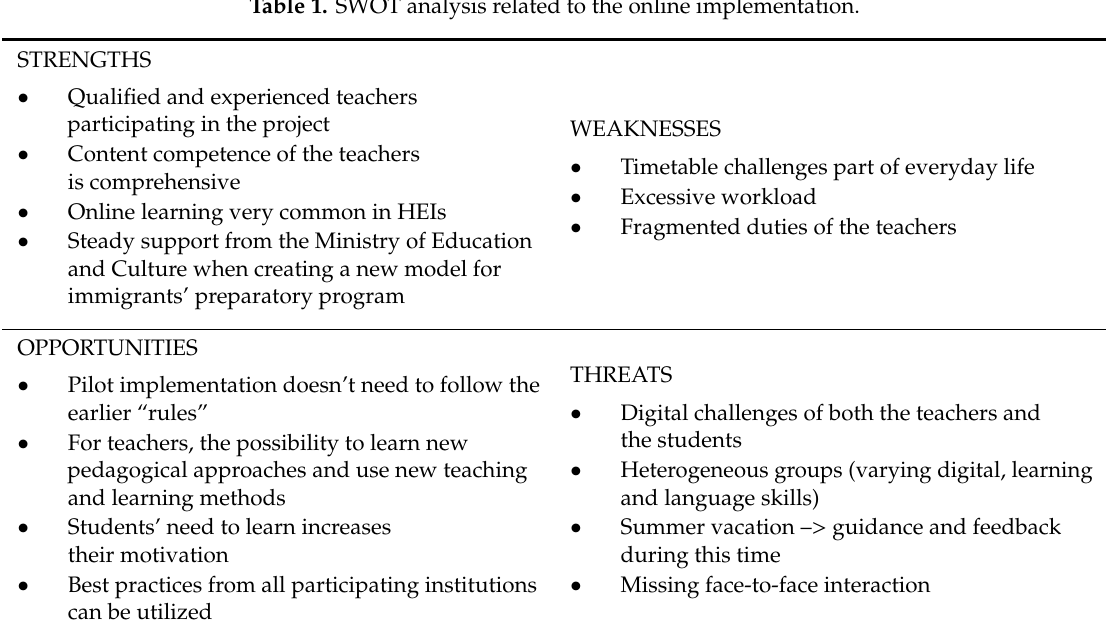
Table 1. SWOT analysis related to the online